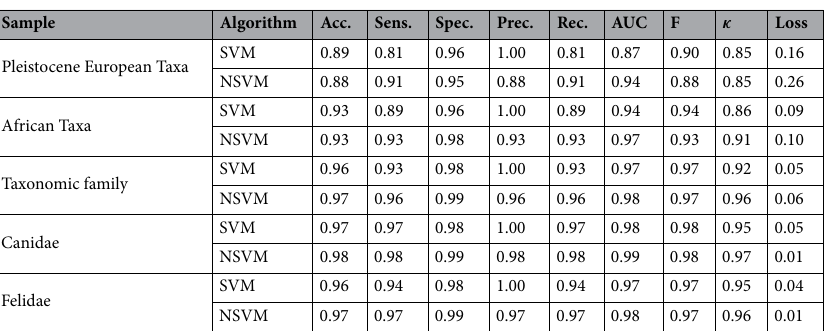
Table 2. Overall classification results obtained for all samples using Support Vector Machines (SVM) and Neural Support Vector Machines (NSVM). Reported values include; Accuracy (Acc.), Sensitivity (Sens.), Specificity (Spec.), Precision (Prec.), Recall (Rec.), Area Under Curve (AUC), F-Measure (F), Kappa ( κ ) and Loss. All evaluation metrics (with the exception of loss) are recorded as values between 0 and 1, with 1 being the highest obtainable value. Values reported over 0.8 are considered an acceptable threshold for powerful classification models. Loss considers values closer to 0 as the most confident